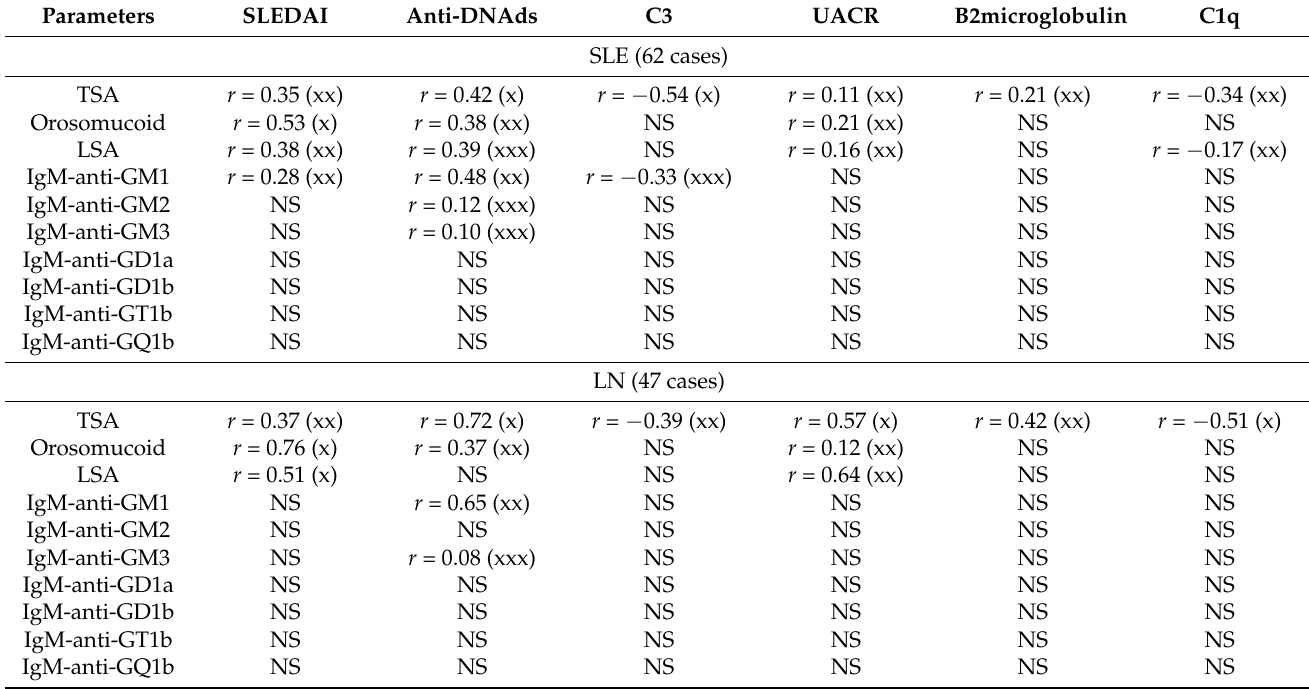
Table 7. Correlation analysis between glycoconjugates/antigangliosides and disease activity markers.